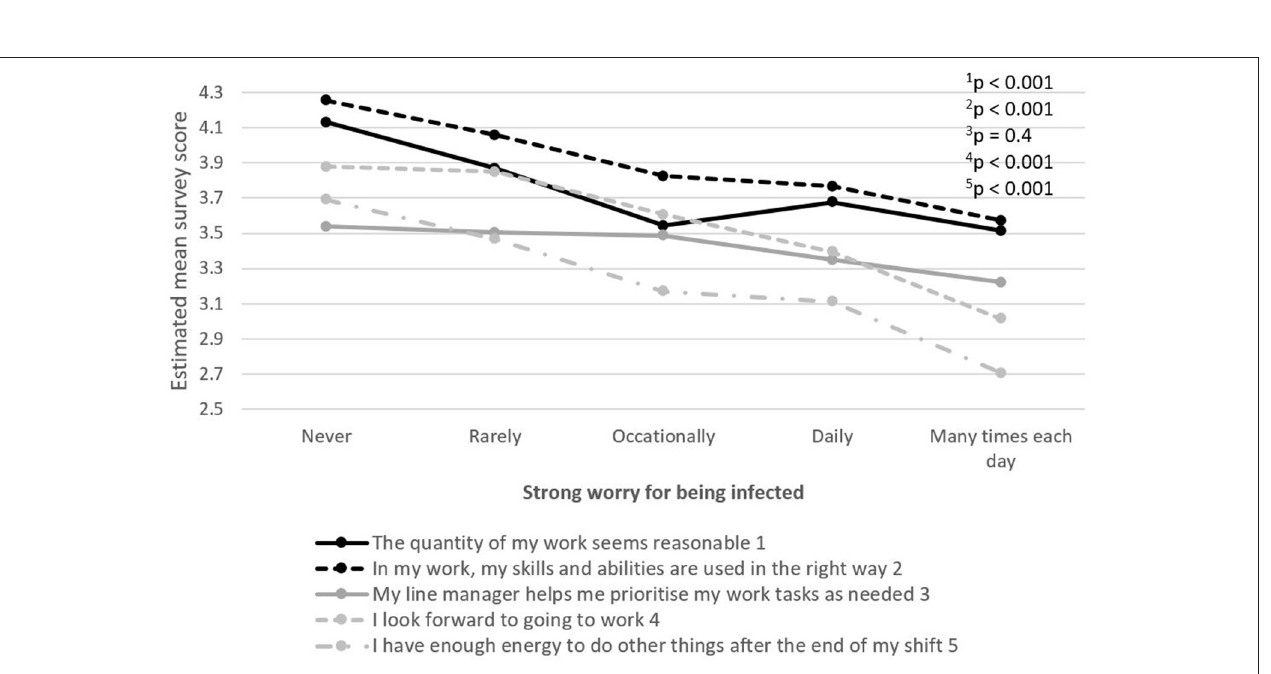
2020 in Sweden. This increased the possibility that